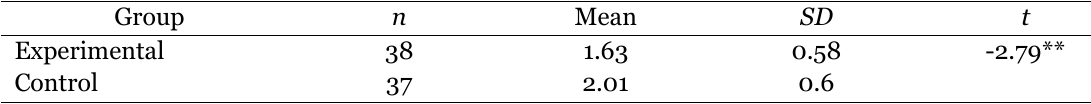
Independent Sample t Test Results for Cognitive Load in Experiment 1 Group n Mean SD t Experimental